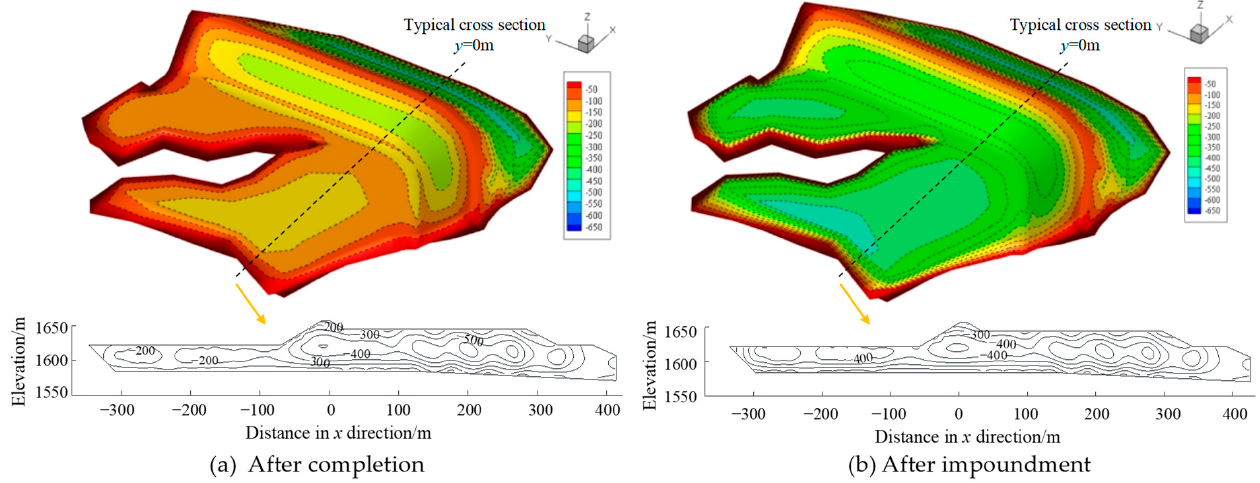
Figure 6. Distribution of vertical displacement (unit: mm): ( a ) after completion; ( b ) after impoundment. According to the vertical displacement results of typical cross sections, after comple- tion, the maximum vertical displacement of the dam rockfill was 505.1 mm at ( x , z ) = ( − 3.5, 1622.2), and the maximum vertical displacement of the reservoir bottom backfill was 276.8 mm at z = 1607 m. After impoundment, the maximum vertical displace- ment of the dam rockfill was 523 mm at ( x , z ) = ( − 11.9, 1622.2), and the maximum vertical displacement of the reservoir bottom backfill was 496.9 mm at z = 1615